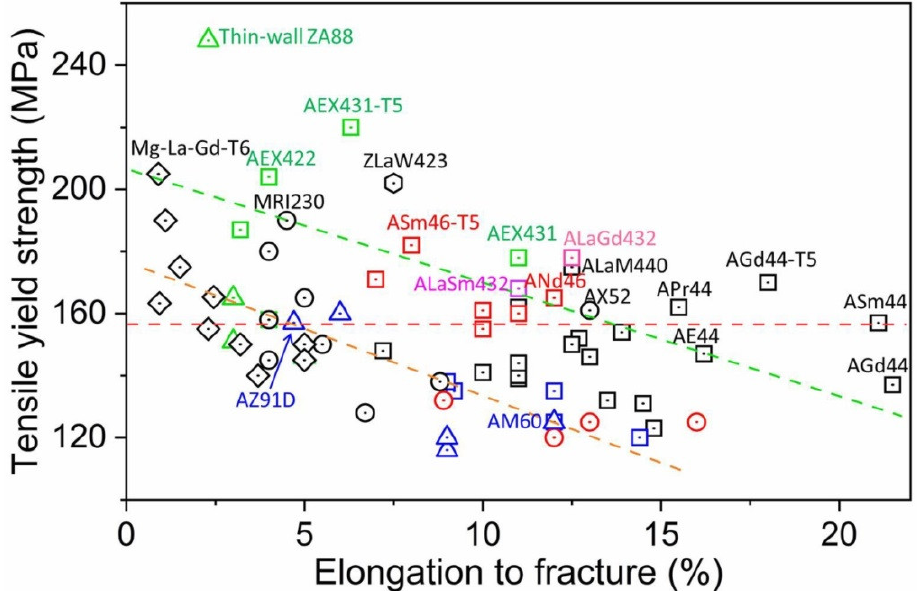
Figure 1. Room temperature TYS versus elongation of various HPDC Mg alloys.